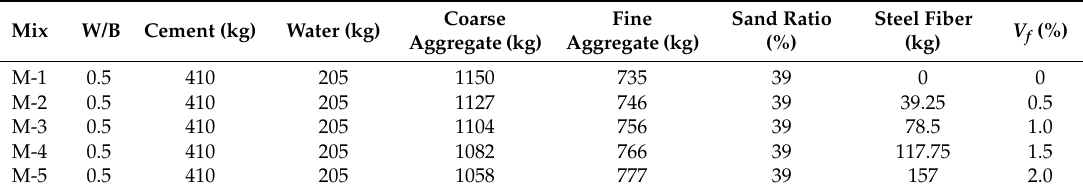
Figure 1. Mill-cut steel fiber. Table 1. Mix proportions.